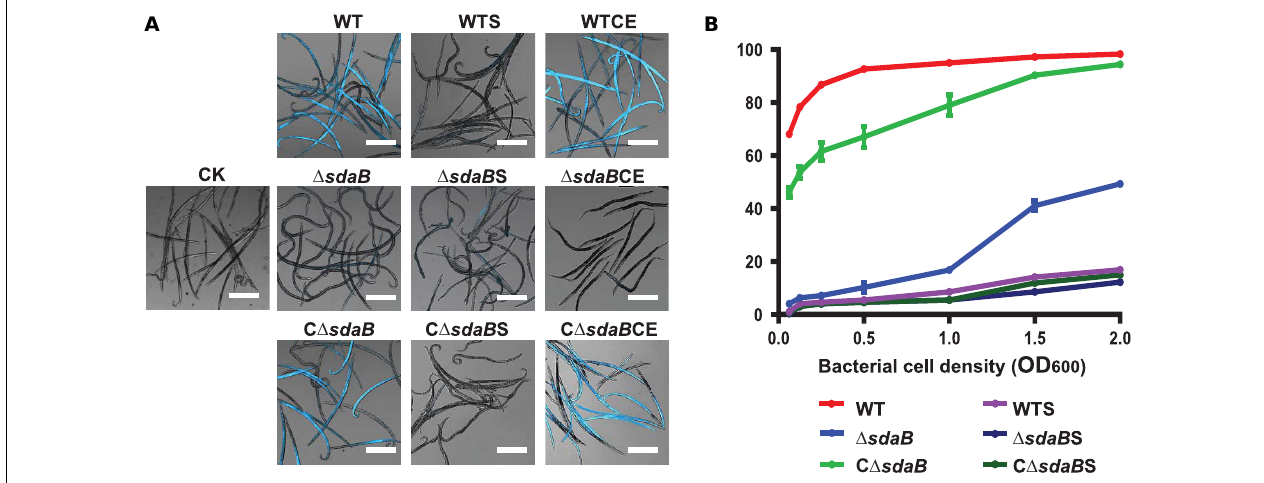
FIGURE 2 | Nematocidal effect of E. ludwigii AA4 and its sdaB gene knock-out mutant against B. xylophilus . (A) Imaging analysis of the PWN-killing efficacy of wild-type E. ludwigii AA4 and AA4 (cid:49) sdaB against B. xylophilus. The dead nematodes showed cyan fluorescence when excited by 353 nm wavelength after being stained by 4 (cid:48) 6-diamidino-2-phenylindole (DAPI), while the live worms stained by DAPI were dim under excitation with the same wavelength. These images were taken using a confocal laser scanning microscope (scale bars: 2 mm). (B) Mortality of the PWNs treated with bacterial cells or culture supernatants. B. xylophilus was co-cultured with cells of wild-type AA4 and AA4 (cid:49) sdaB or incubated with culture supernatants of wild-type AA4 and AA4 (cid:49) sdaB for 24 h, respectively. CK, sterile LB liquid medium; WT, cell culture of wild-type AA4; WTS, supernatant of wild-type AA4 culture; WTCE, cell extract of wild-type AA4; (cid:49) sdaB , cell culture of AA4 (cid:49) sdaB ; (cid:49) sdaB S, supernatant of AA4 (cid:49) sdaB culture; (cid:49) sdaB CE, cell extract of AA4 (cid:49) sdaB ; C (cid:49) sdaB , cell culture of AA4 (cid:49) sdaB complemented with the wild-type sdaB gene; C (cid:49) sdaB S, supernatant of culture of AA4 (cid:49) sdaB complemented with the wild-type sdaB gene; C (cid:49) sdaB CE, cell extract of AA4 (cid:49) sdaB complemented with the wild-type sdaB gene.